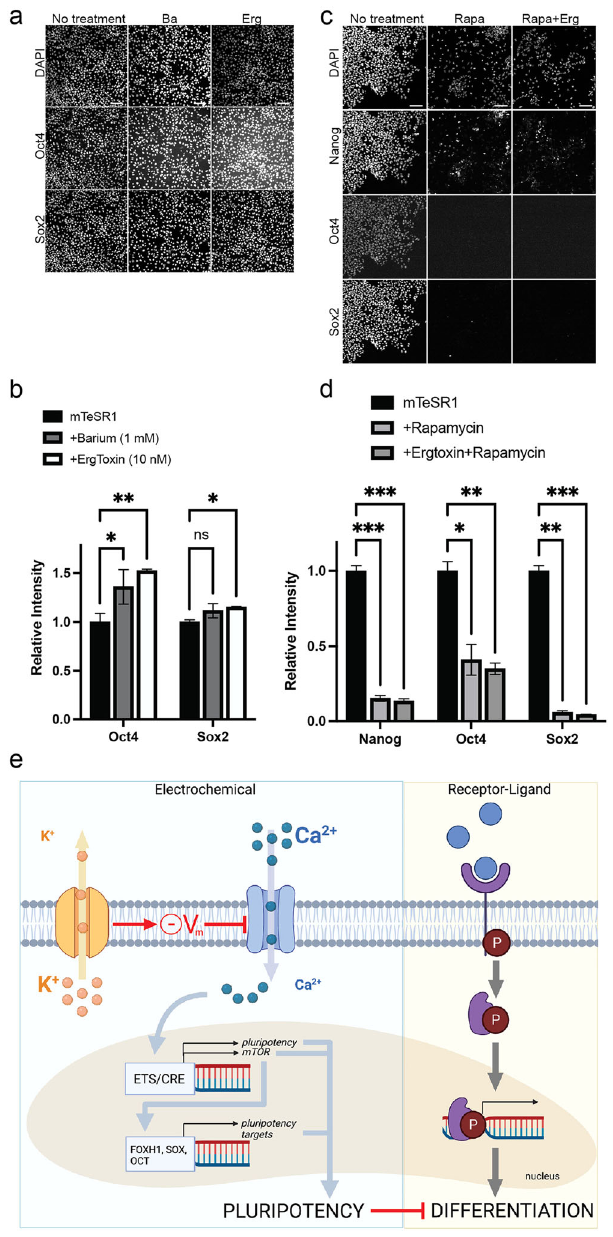
Fig. 8 | Potassium channels affect pluripotency in hESCs. a Images showing untreated hESCs grown in mTeSR1 media or cells treated with 1mM Barium or 25nM Ergtoxin and immunostained for pluripotency factors. Scale bar=100 μ m. b Quanti fi cationoftheresultsin a ;AUarbitraryunits. p -valuesareOct4:(controlvs Ba)=0.03, (control vs Erg)=4.5e-04; Sox2 (control vs Ba)=0.06, (control vs Erg)=4.4e-04. c Imagesshowing untreated hESCsgrowninMEF-CMmediaorcells treatedwith100nMrapamycinwithorwithout25nMErgtoxin.Scalebar=100 μ m. d Quanti fi cation ofthe results in c ; AU arbitraryunits. p -values are Nanog: (control vs Rapa)=4.5e-04, (control vs Rapa+Erg)=4.3e-04; Oct4: (control vs Rapa)= 0.002, (controlvsRapa+Erg)=0.002;Sox2(controlvsRapa)=7.7e-04,(controlvs Rapa+Erg)=7.6e-04. Graphs ( b ) and ( d ) present mean±SEM; key for asterisks: * p ≤ 0.05, ** p ≤ 0.01; *** p ≤ 0.001; ns nonsigni fi cant for p <0.05; data were derived